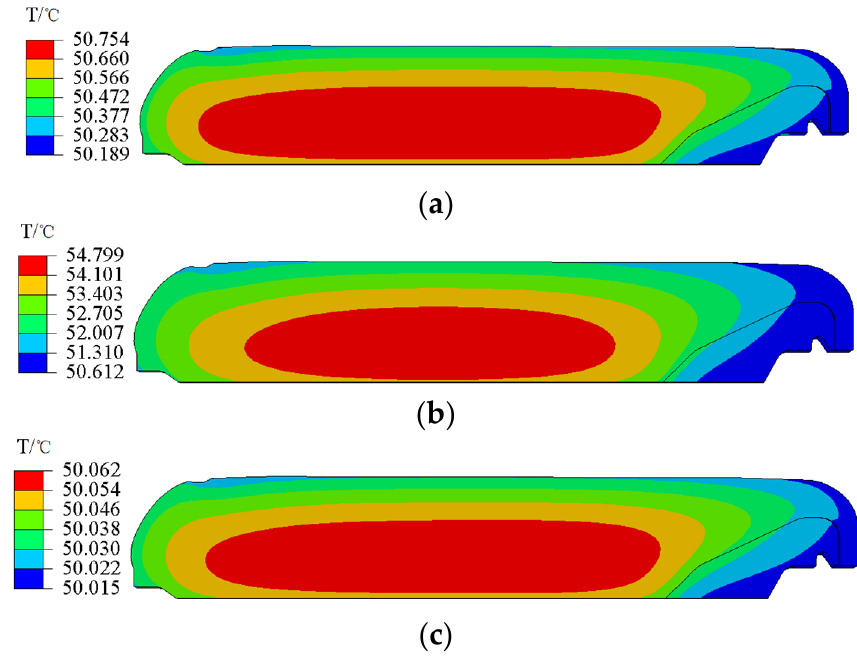
Figure 5. Contours of the temperature. ( a ) 24 h . ( b ) 72 h . ( c ) 168 h . Figure 6 depicts the curing degree of the NEPE propellant grain cured at 50 ◦ C for 24 h, 72 h, and 168 h. It can be seen that the curing degree show the same distribution trends as temperature. The curing degree in the center of the propellant grain is higher than that in the periphery. At the end of curing, the curing degree in the interior of the grain tends to be uniform, reaching above 0.997.